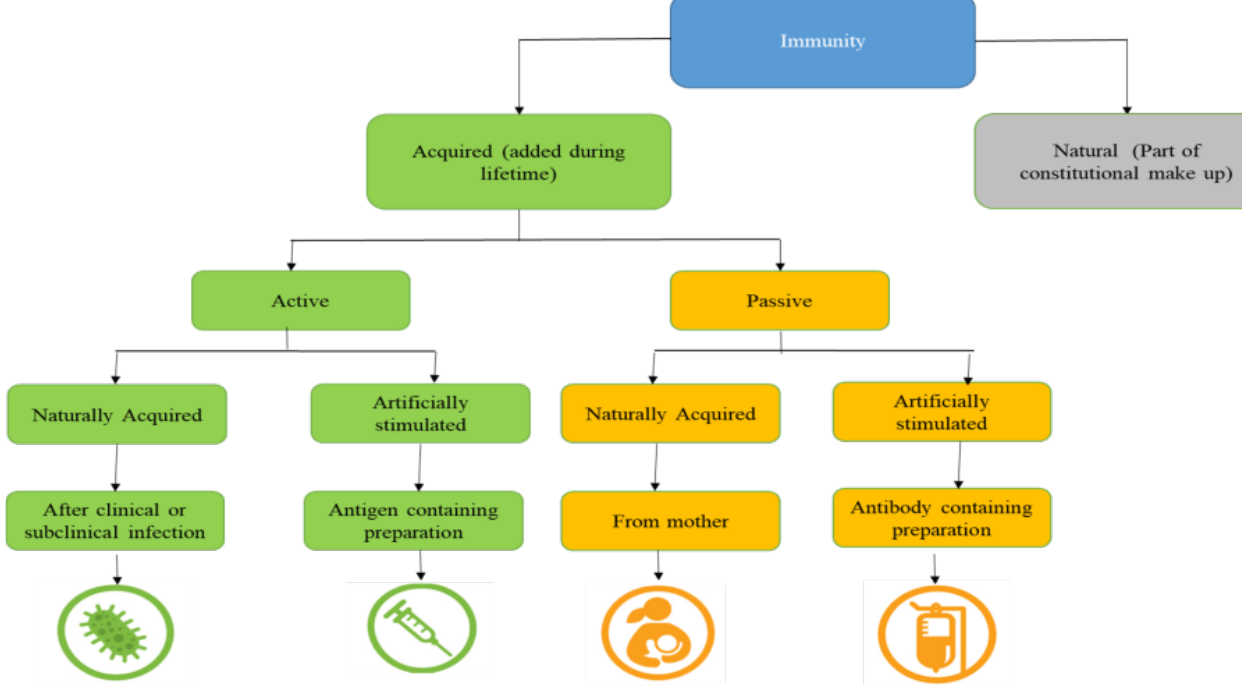
FIGURE 1 - Different types of